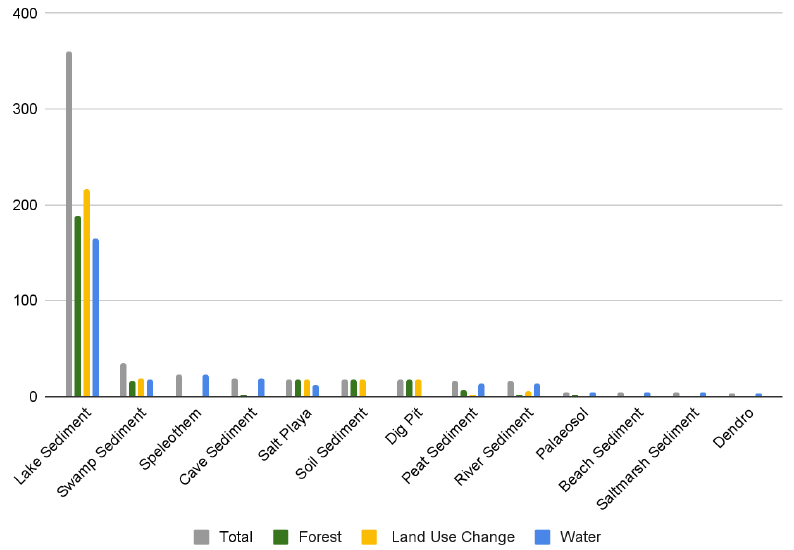
Figure 6. Number of studies extracted from different environmental archives.